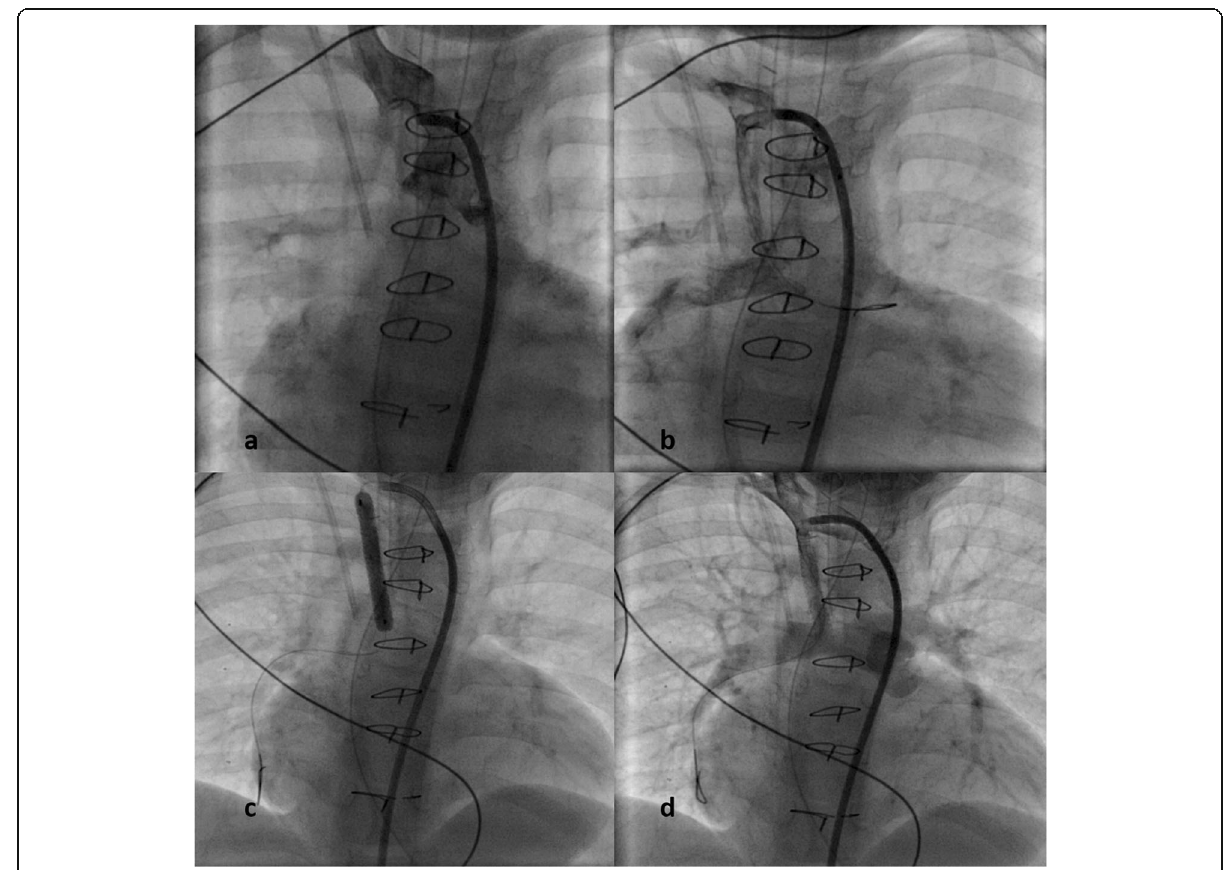
Fig. 1 Serial fluoroscopy stills in the posteroanterior projection with 20° cranial angulation. In a , right subclavian artery angiography fails to opacify the Blalock-Taussig shunt, but is opacified in the angiogram after wiring and balloon dilatation ( b ). After parking the coronary wire in the distal right pulmonary artery, stent was deployed ( c ) restoring the entire lumen of the shunt opacifying both pulmonary arteries ( d